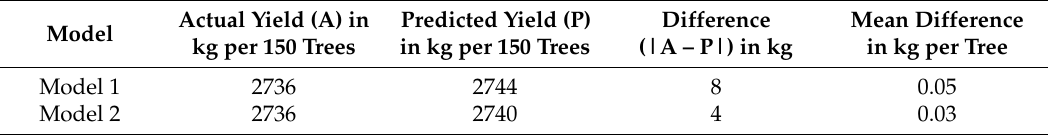
Table 6. Comparison between actual yield and predicted yield; n = 150 trees.